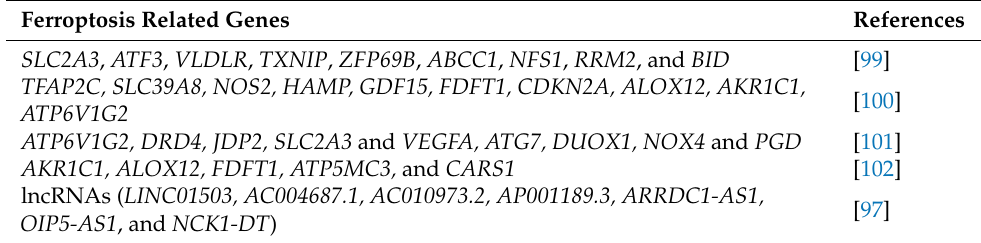
Table 3. Ferroptosis related genes used as diagnostic and prognostic markers in CRC patients. Ferroptosis Related